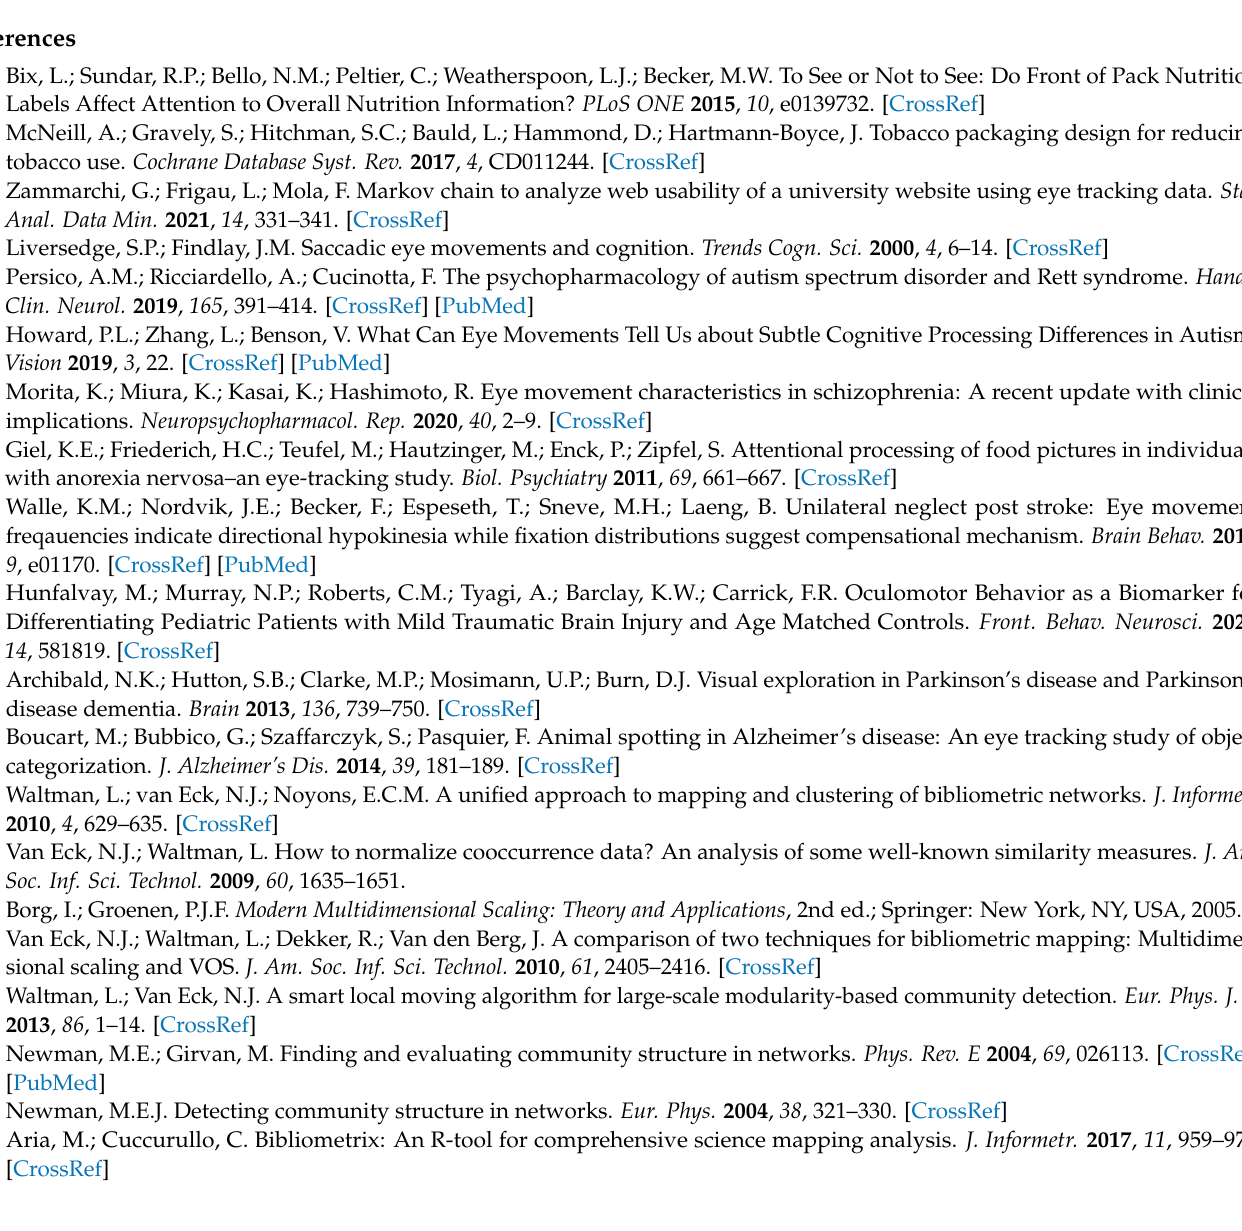
Table S5: World collaboration network for articles investigating the use of eye tracking in autism spectrum disorders; Table S6: Most cited countries based on number of total citations for articles focused on autism spectrum disorders; Table S7: Institutions with highest numbers of retrieved articles focused on autism spectrum disorders based on authors affiliations. Figure S1: Annual scientific production growth of all articles retrieved in our search; Figure S2: Annual scientific production growth of articles that applied eye tracking to the study of autism spectrum disorders; Figure S3: Country collaboration network of articles that applied eye tracking to the study of autism spectrum